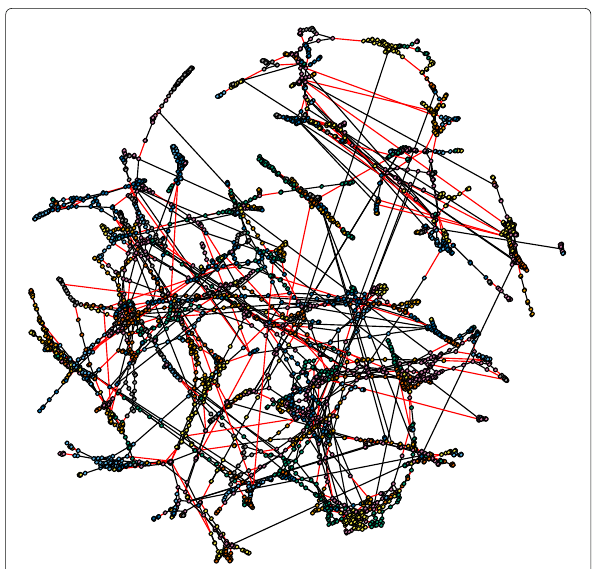
Fig. 12 Power network topology of the Western States Power Grid of the USA